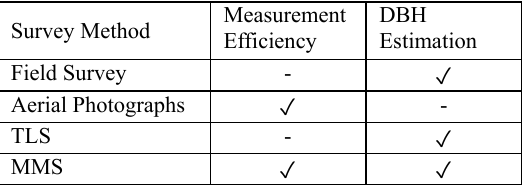
Table 1 . Comparison of roadside tree survey